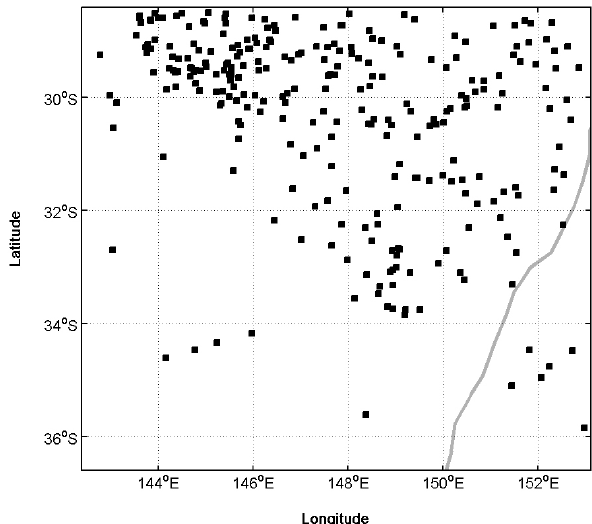
Fig. 12. The positions of the unmatched locations from the WWLL data set (black squares), in the same format as Fig.